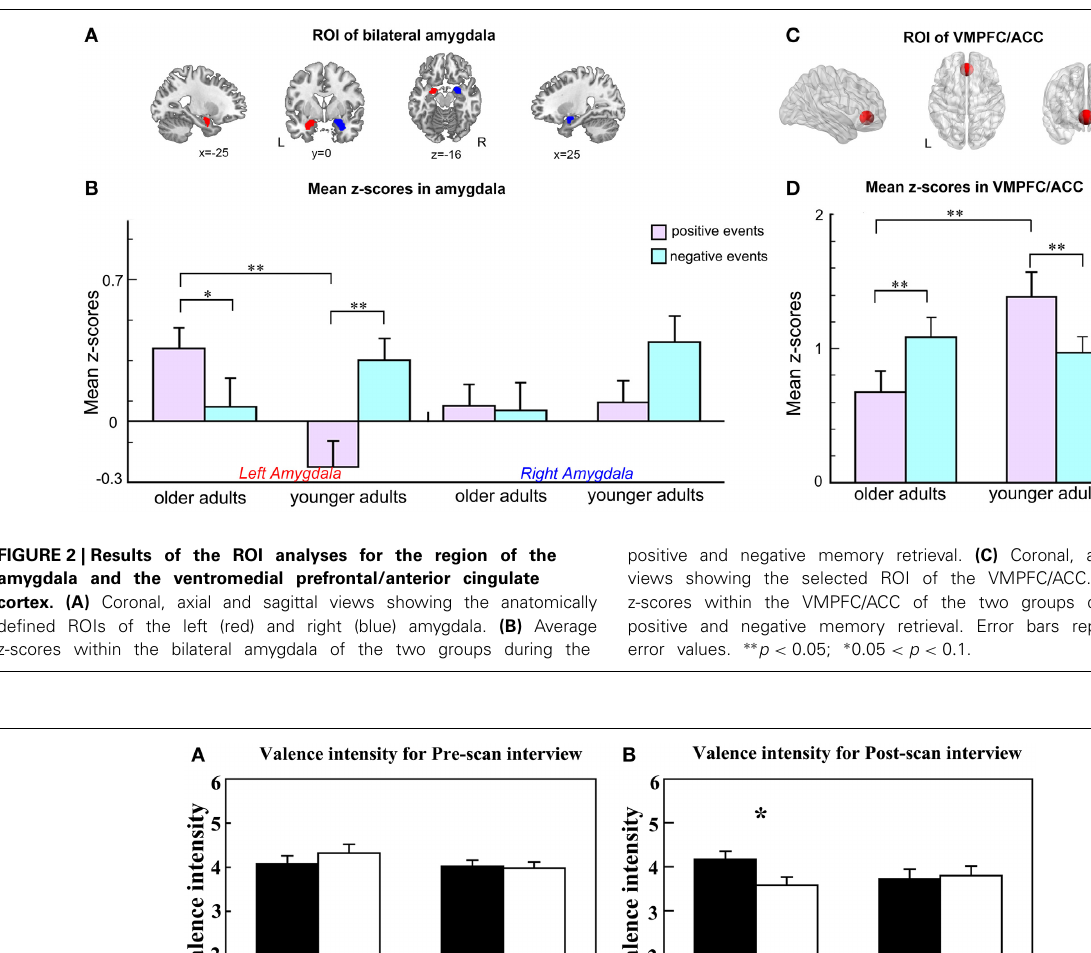
FIGURE 3 | Results of behavioral data in (A) pre-scan and (B) post-scan interviews in terms of emotional valence intensity. ∗ p < 0 . 05. The error bars represent standard error values.